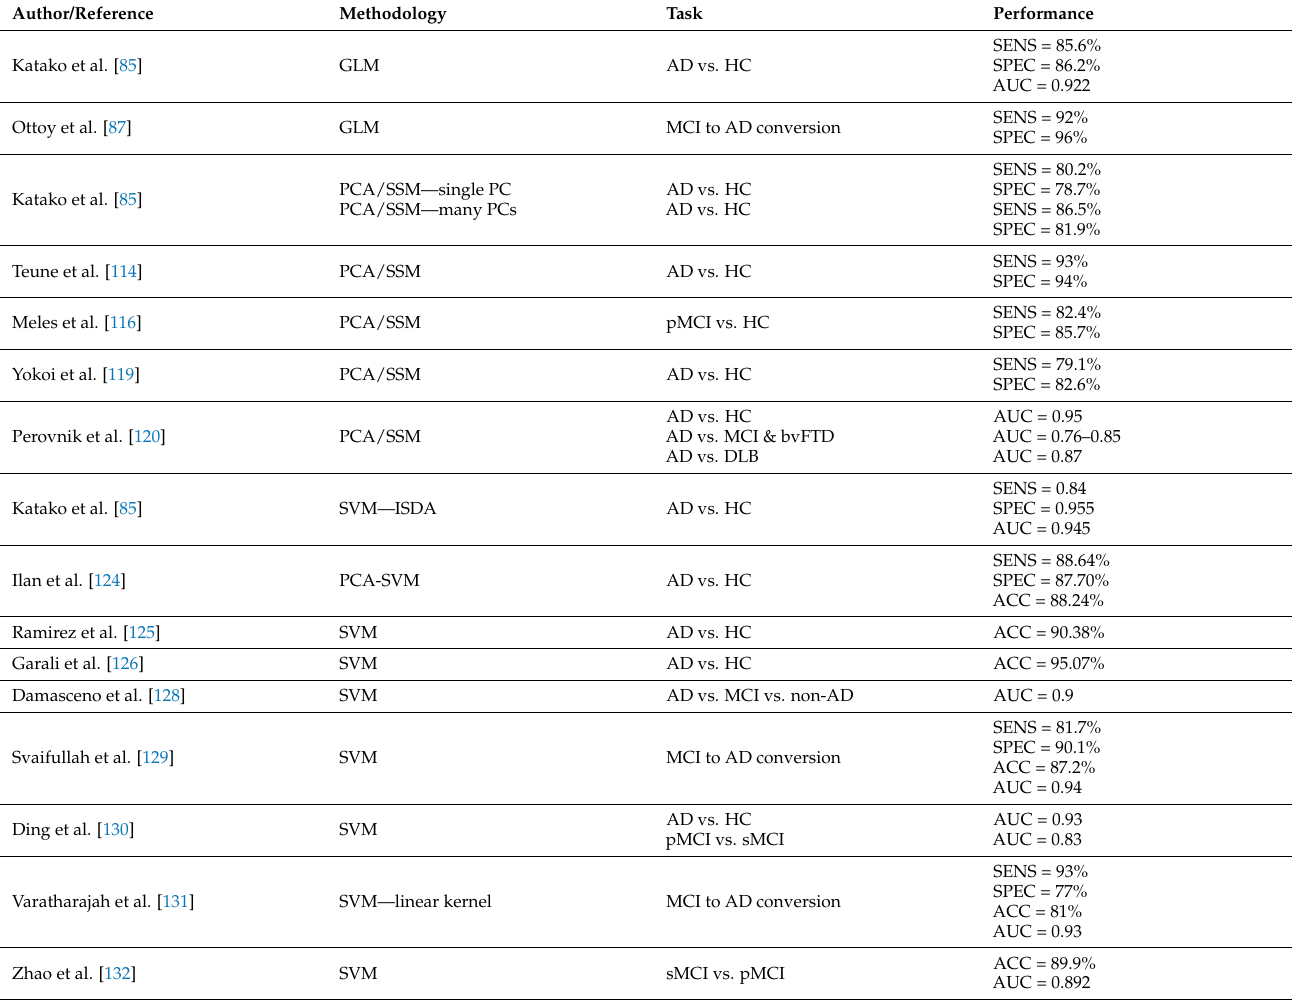
Table 1. Summary of literature for the identification/classification/prognostication of AD. All studies reporting some combination of sensitivity (SENS), specificity (SPEC), area-under-curve (AUC), or accuracy (ACC) have been considered for inclusion. The use of GLMs is widespread throughout statistical analysis software and programming languages and provides a reliable tool for accounting for the effects of covariates, such as age and sex, with some use as a stand-alone classifier for AD detection. More specialized methods based on the ideas of the GLM, such as 3D-SSP, are engineered for the detection of AD pathology, and progress in research into applying this technique to amyloid and tau imaging is underway. PCA and SSM are both extremely valuable tools for dimensionality reduction (the elimination of unnecessary or redundant data) and the discovery of disease-specific patterns. They are also quite effective prior to classification with an SVM and increase classification accuracy. From the literature surveyed in this review, deep learning-based tools provide the greatest accuracy for differentiating AD patients from healthy controls, differentiating AD from MCI patients, and the clinically relevant task of differentiating pMCI and sMCI